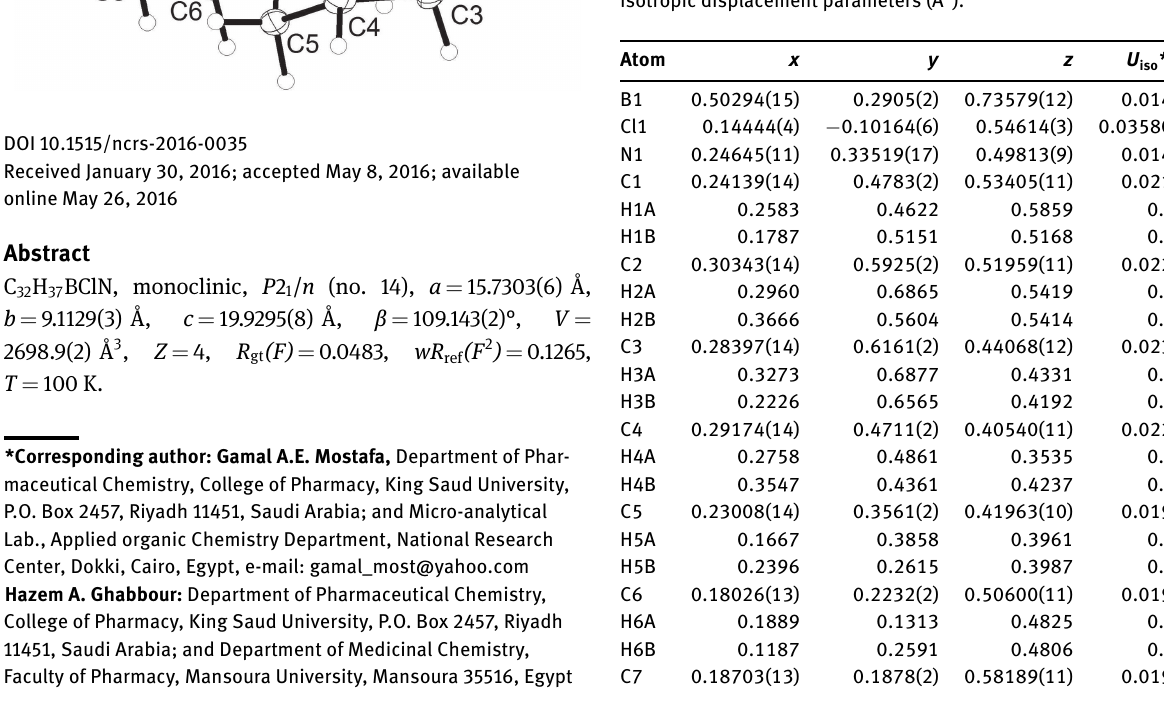
Table 2: Fractional atomic coordinates and isotropic or equivalent isotropic displacement parameters (Å 2